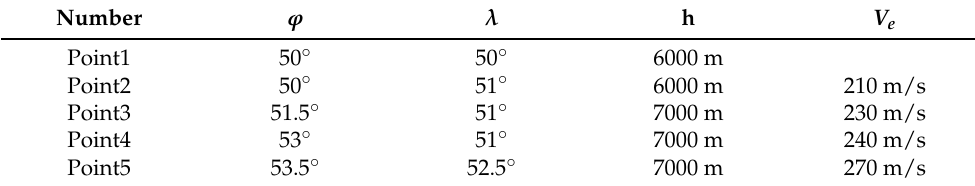
Table 4. Waypoint settings in Section 5.2.